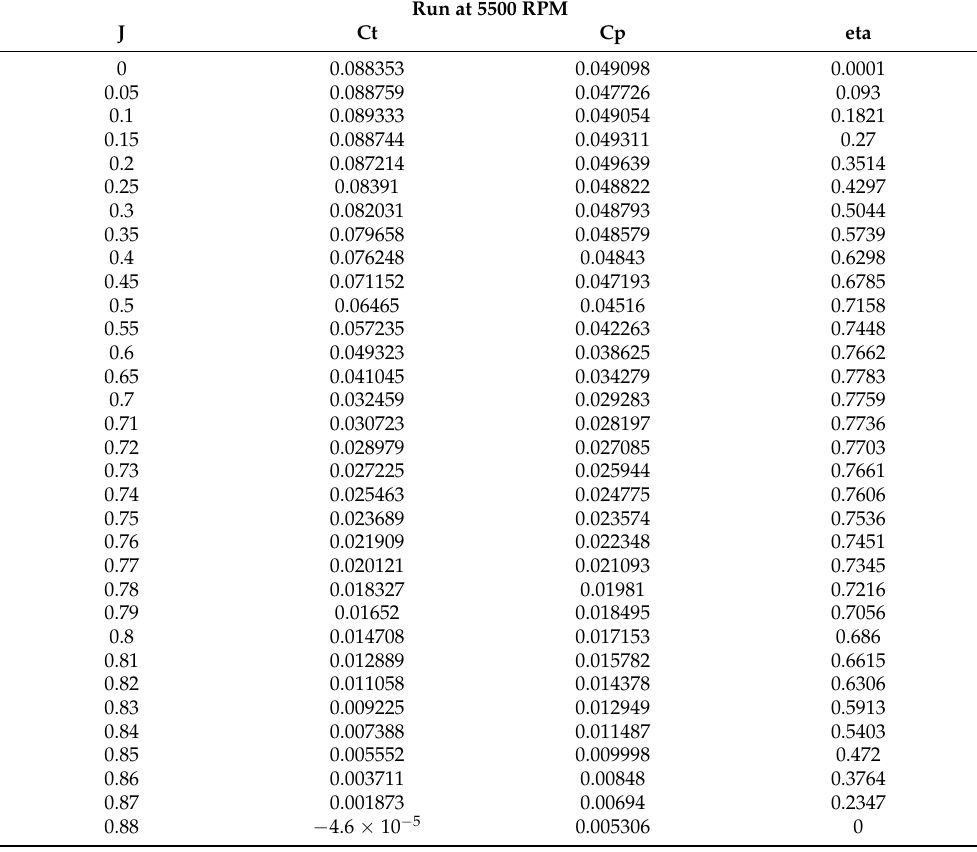
Table A21. BEMT 16 × 12 APC propeller data.